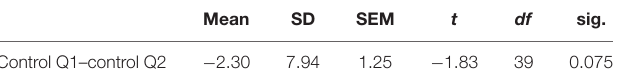
TABLE 3 | Paired samples t -test results of the control group’s reflective thinking level. Mean SD SEM df sig.